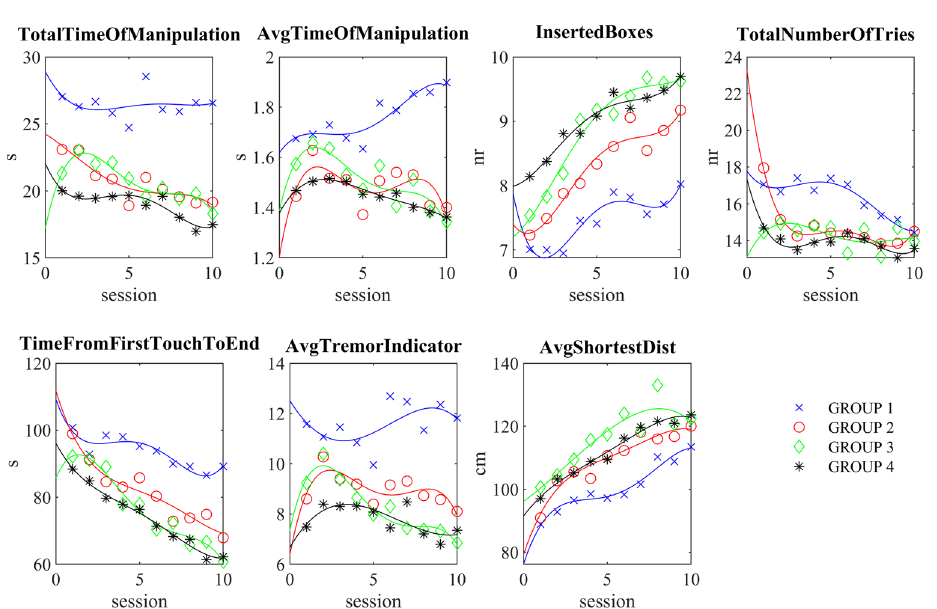
Figure 4. The cognitive tests D- KEFS, JLO, FAB showed rather small differences of median scores between groups and low average to high average scores, which means that the participants were not severely cognitively impaired.